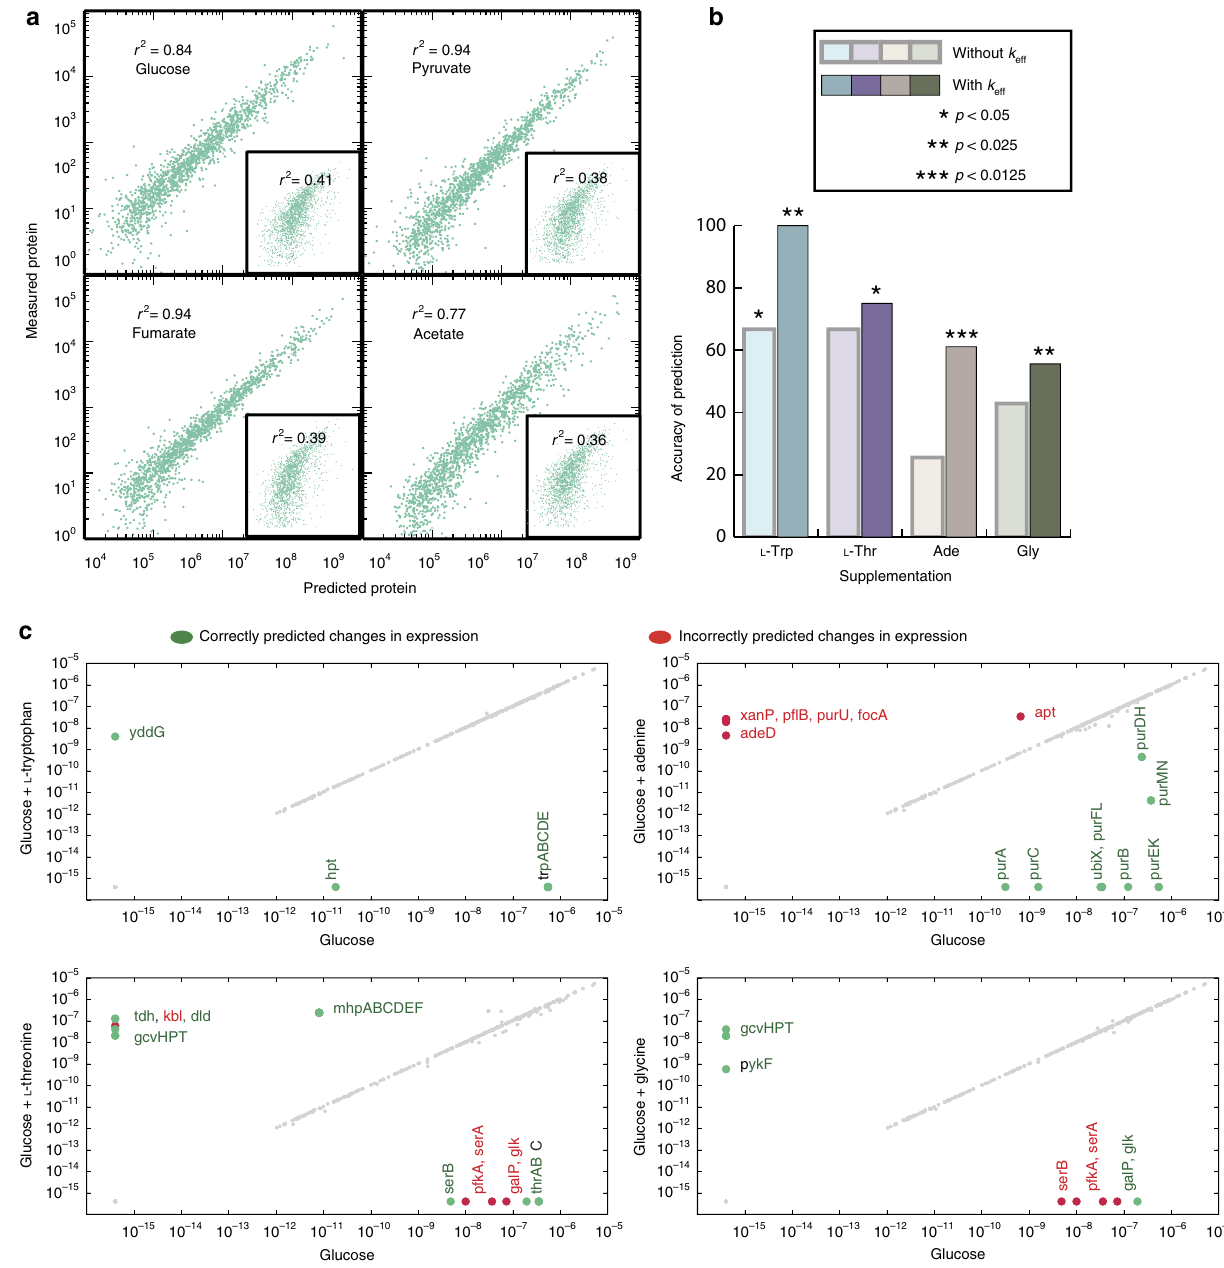
Figure 5 | Predicting the results of perturbation from a parameterized homeostatic state. ( a ) Using a cross-validation approach, protein abundance is predicted by mRNA levels using information ( r PM ) obtained from other conditions ( r 2 4 0.75). Condition-specific mRNA and protein levels show little correlation (inset). ( b ) Accuracy of predicting differential expression is significantly enhanced using k eff parameters. ( c ) Predictions of differential gene expression using enhanced k eff parameters after media supplementation. The predictions were validated using expression profiling and gave predictive accuracies range between 56 and 100%. In all cases, predictions of differentially expressed genes are significantly enriched for those which have been experimentally confirmed ( p o 0.05 using a hypergeometric distribution).